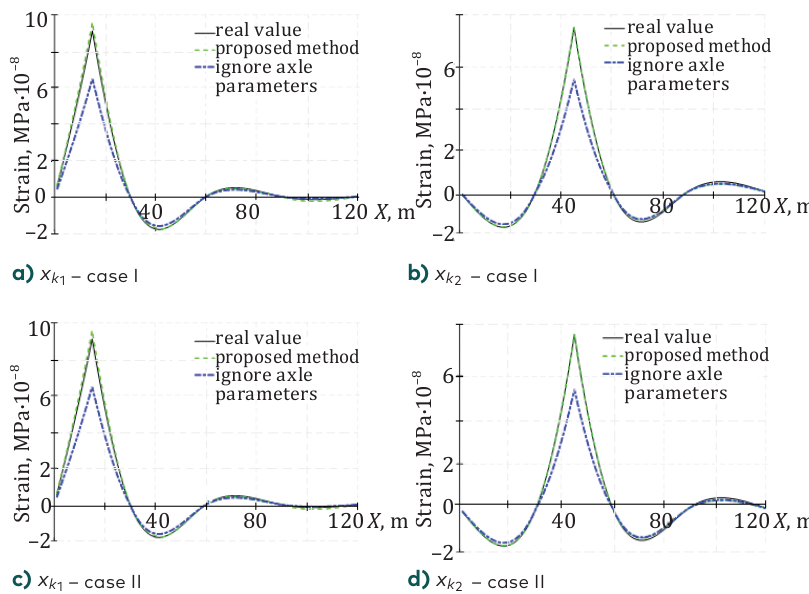
Figure 17. Comparison of modified strain influence line and the theoretical curve for different lane